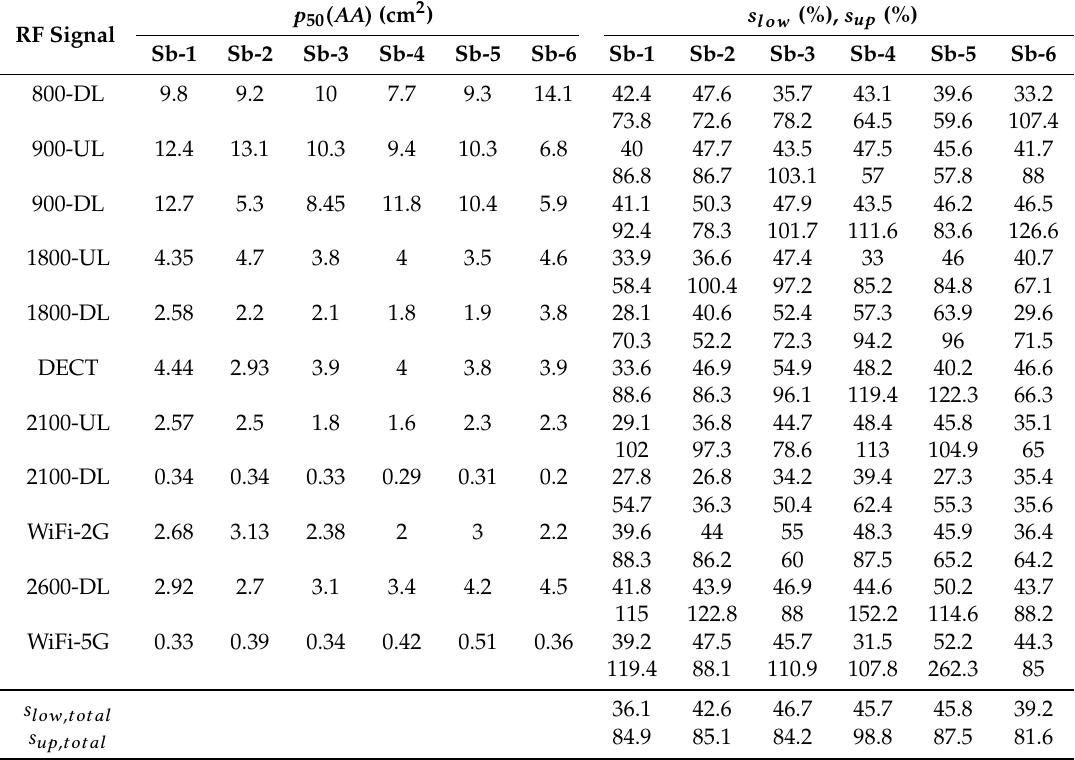
Table 6. Studied frequency bands and their median on-body antenna apertures determined from calibration measurements on six subjects and uncertainties due to the presence of human body on the average of two nodes in each frequency